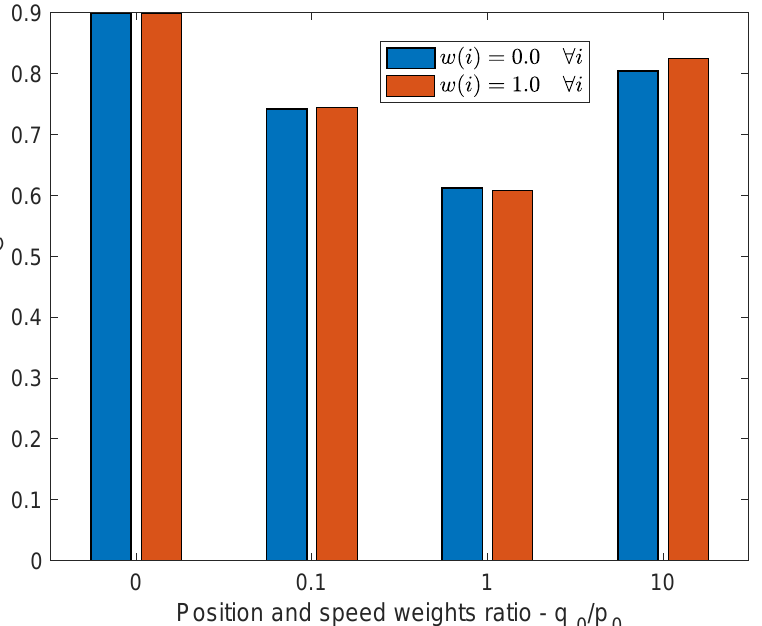
Figure 6. Sensitivity analysis on the objective function weights. Position error at the altitude of 30 km